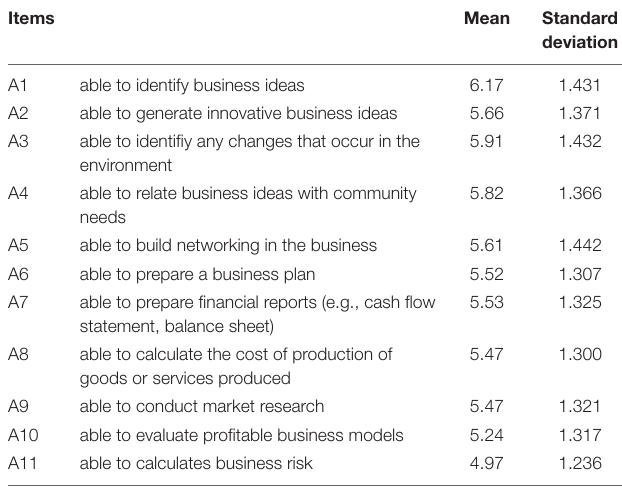
TABLE 3 | Items of entrepreneurship education.